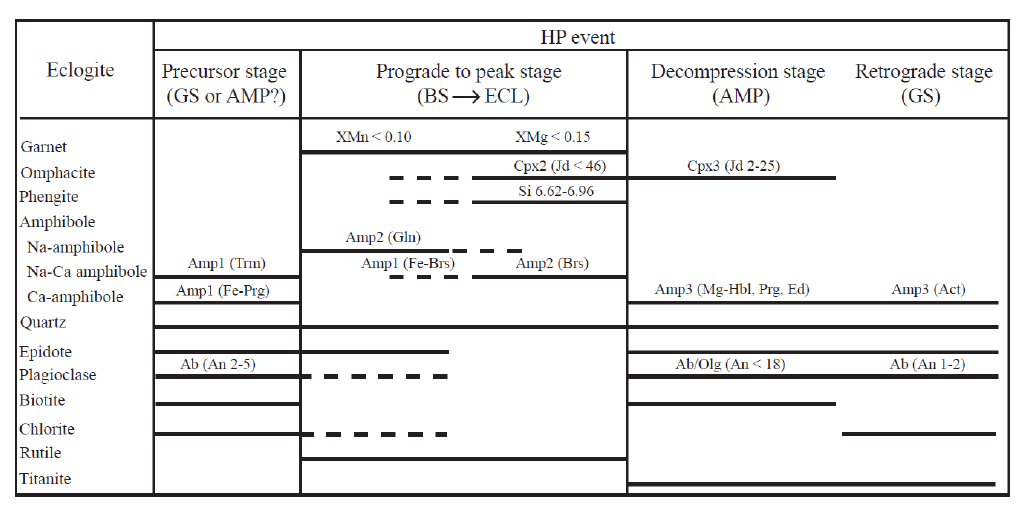
Figure 9. paragenesis of eclogites. ECL, eclogite facies; BS, blueschist facies; AMP, amphibolite facies; GS, greenschist facies.